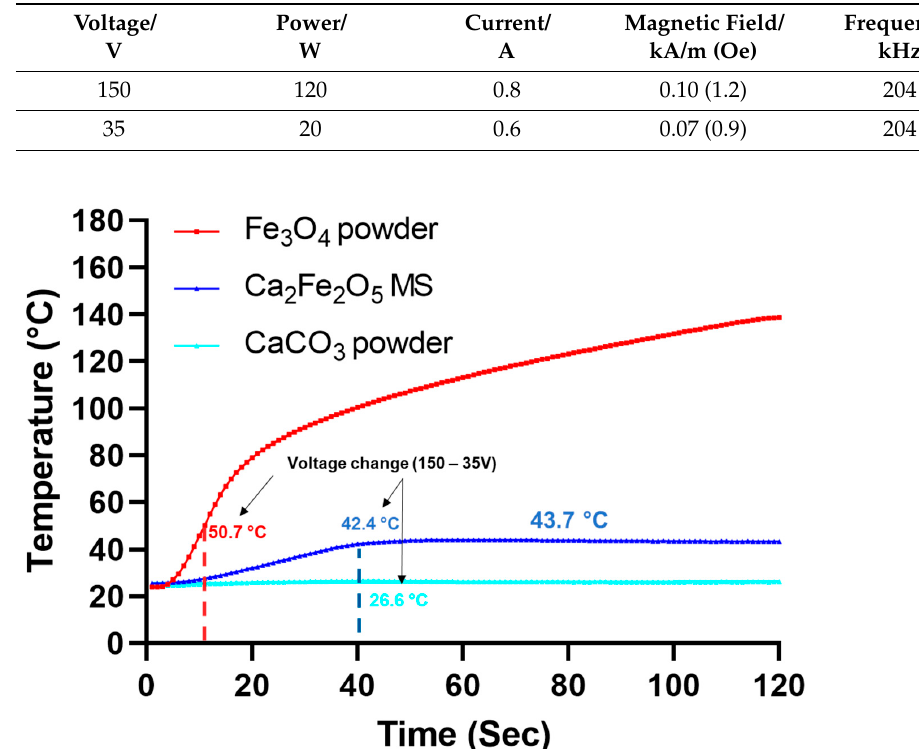
Figure 8. Induction heating curves for flame spheroidised Ca 2 Fe 2 O 5 microspheres (MS), compared with Fe 3 O 4 and CaCO 3 starting powders. Homogenous Ca 2 Fe 2 O 5 microsphere exhibited highly stabilised temperature control. (All curves display averages of triplicate measurements) (Statistical analysis on Supplementary Materials, Table S4). Table 7. Experimental parameters for induction heating investigations.